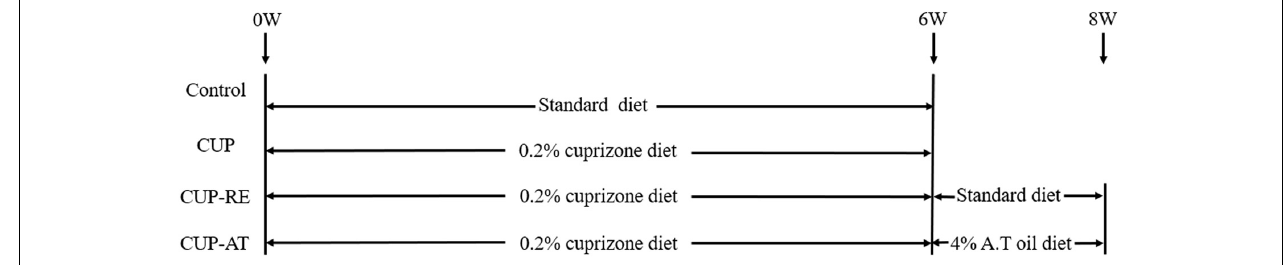
FIGURE 1 | Experimental time course image.